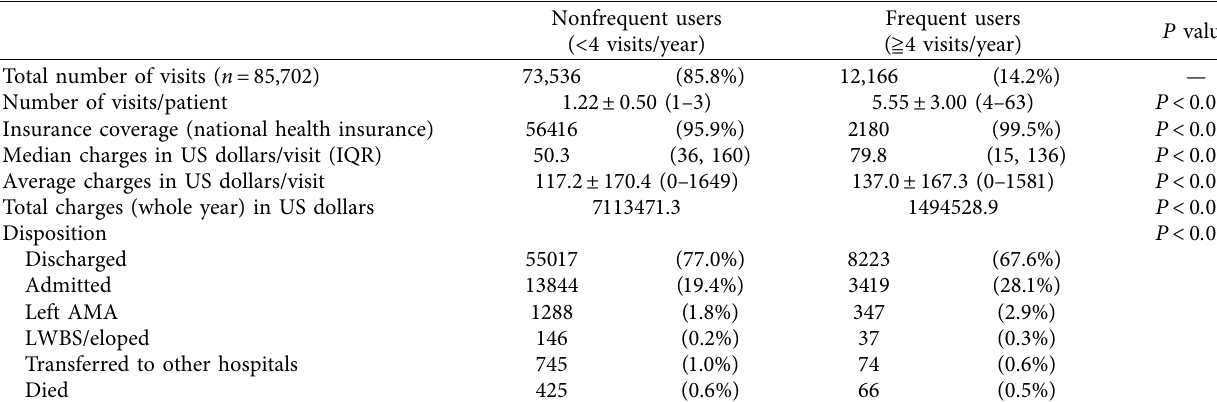
Table 3: Expense and disposition of frequent and nonfrequent